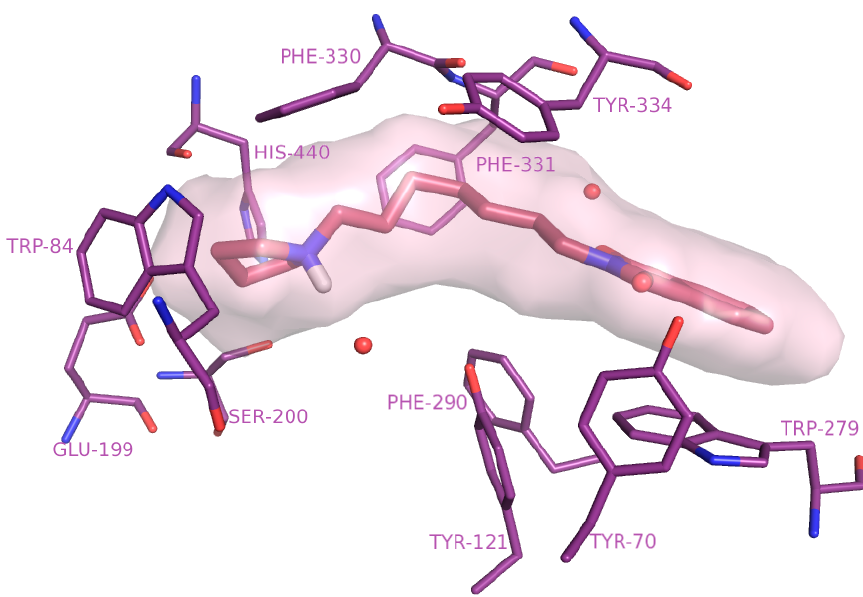
Figure 3. The binding mode of compound 3 (pink) within the active site of AChE.